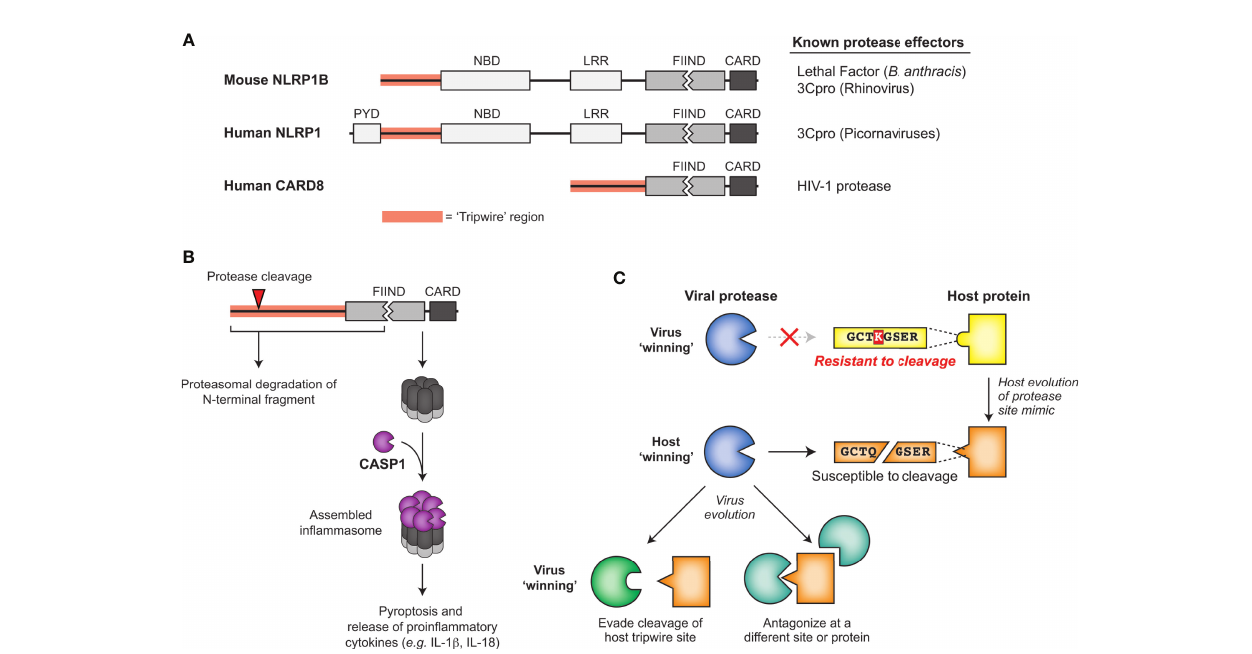
FIGURE 6 | Sensing of pathogen-encoded protease activities by host ‘ tripwires ’ . (A) NLRP1 and CARD8 serve as effector-triggered immunity (ETI) sensors to detect cleavage by viral proteases. Schematic of mouse NLRP1B, human NLRP1, and human CARD8, highlighting the tripwire region (left) and the known protease effectors (right). (B) Model for how protease cleavage initiates functional degradation of the N-terminal region of in fl ammasome activators. Activation recruits and activates caspase-1, which cleaves multiple host proteins, including processing proin fl ammatory cytokines such as IL-1 b , into their mature, bioactive form. (C) Model for how evolution of host protease site mimics may drive viral protease evolution to either evade cleavage of the host tripwire or antagonize the host in other parts of the protein or